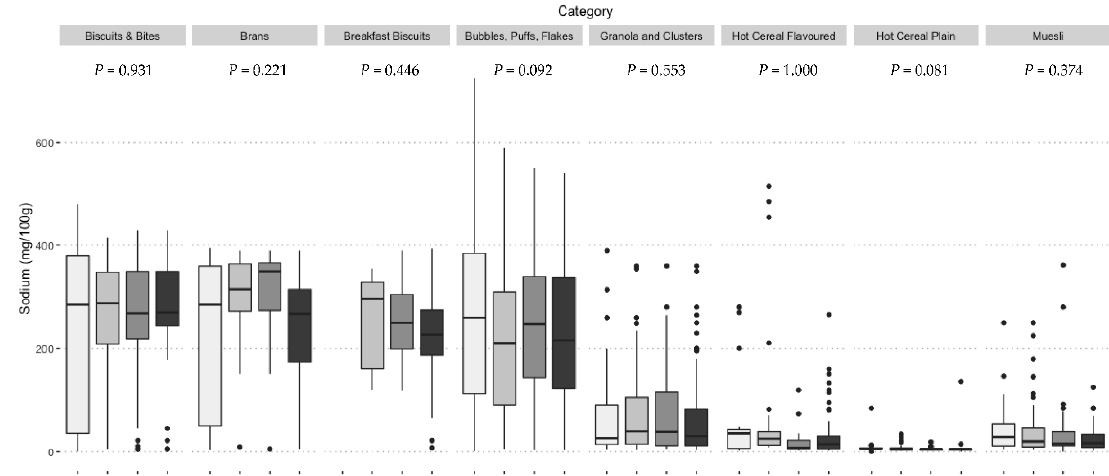
Figure A4. Sodium content of breakfast cereals (g/100 g) between 2013, 2015, 2018, and 2020; p value comparing 2013 vs. 2020 (2015 vs. 2020 for breakfast biscuits). * Statistically significant p < 0.05 .